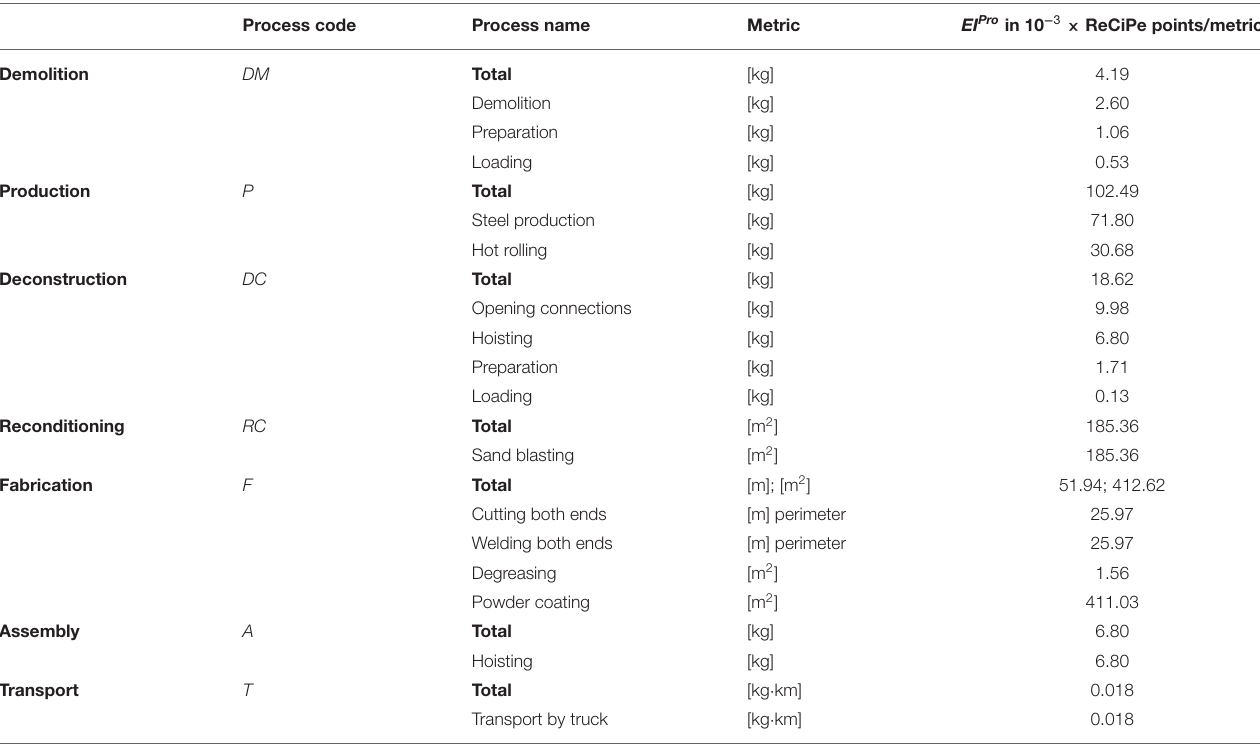
TABLE 1 | Environmental impacts of “new” and “reuse” route processes (Brütting et al.,